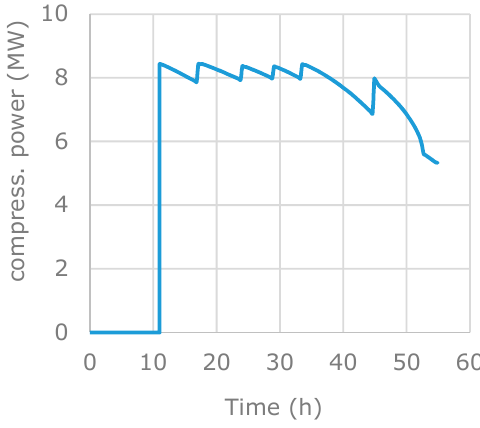
Figure 20. Compressor power (winter unloading).